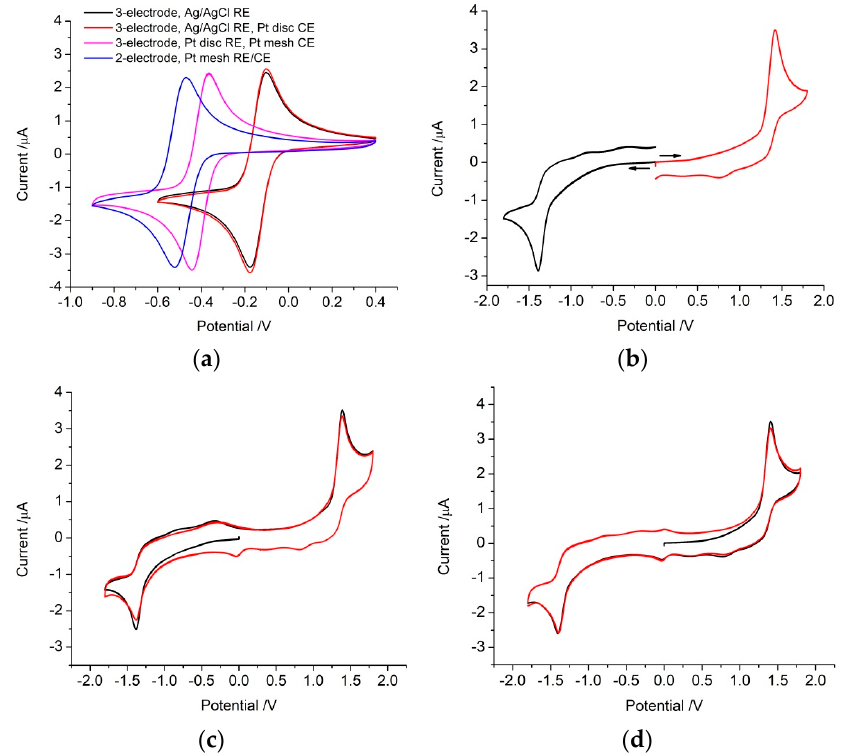
Figure 4. Cyclic voltammetry of a platinum electrode in degassed 0.1 M NaCl with 5 mM Ru(NH 3 ) 63+ at a scan rate of 100 mV s − 1 in a ( a ) three- or two-electrode configuration, ( b – d ) two- electrode configuration with a platinum disc reference/counter electrode over different potential ranges and directions, ( b ) starting from 0 V scanning either positive or negative, ( c ) two cycles scanning negatively, ( d ) two cycles scanning positively. ( d ) two cycles scanning